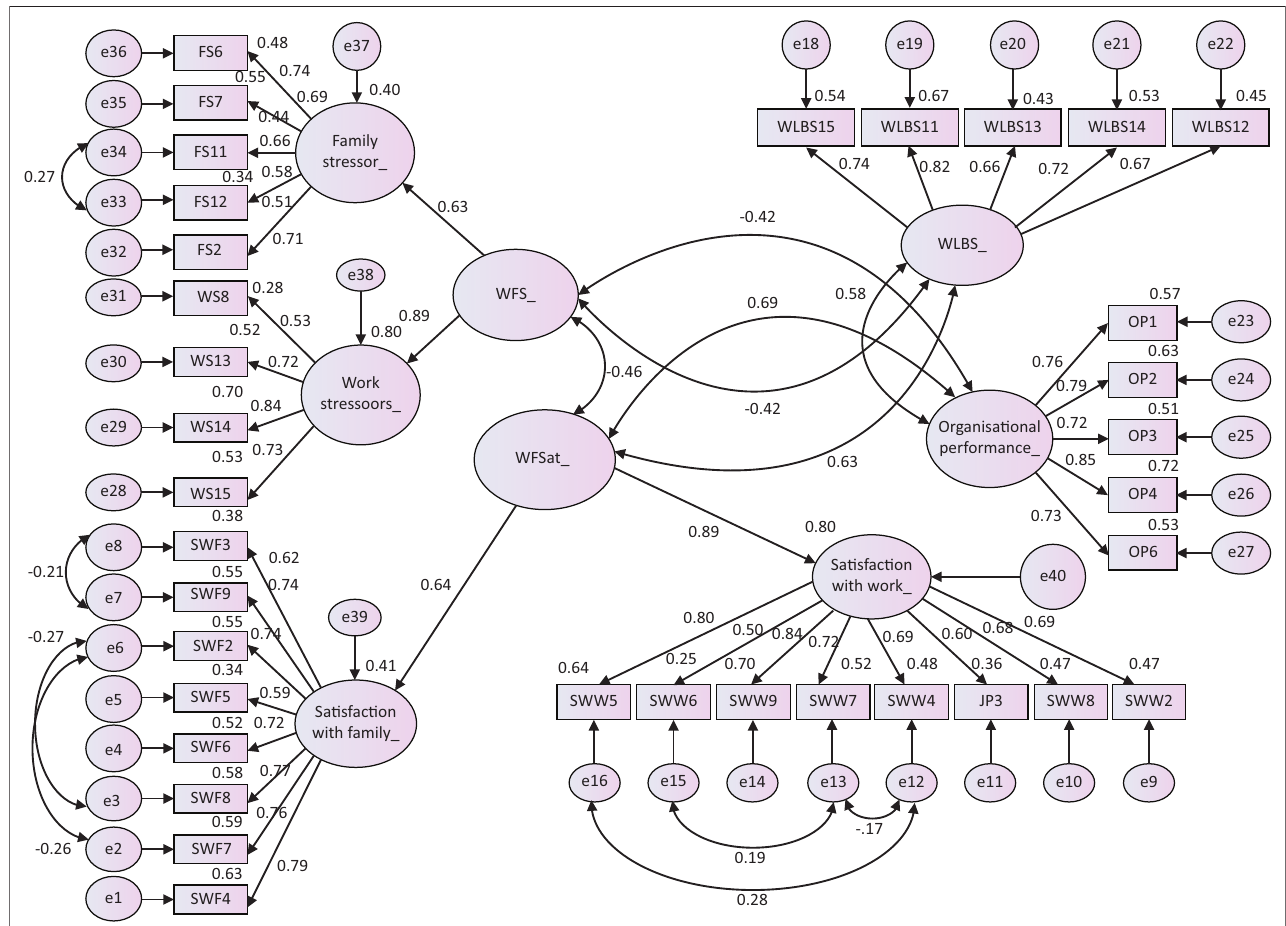
FIGURE 2: Hypothesised four-factor model (second-order ss).